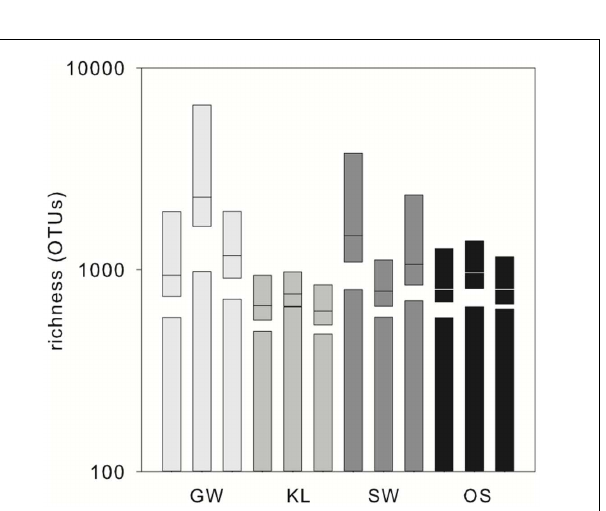
intermediate gray, and OS black symbols. Symbols are grouped with a hand-drawn ellipses to better illustrate how symbols cluster in MDS space. (B) Multi-dimensional scaling (MDS) of Bray–Curtis similarity index for pyrosequencing data for the inflow slice of triplicate reactors from each of four treatments.